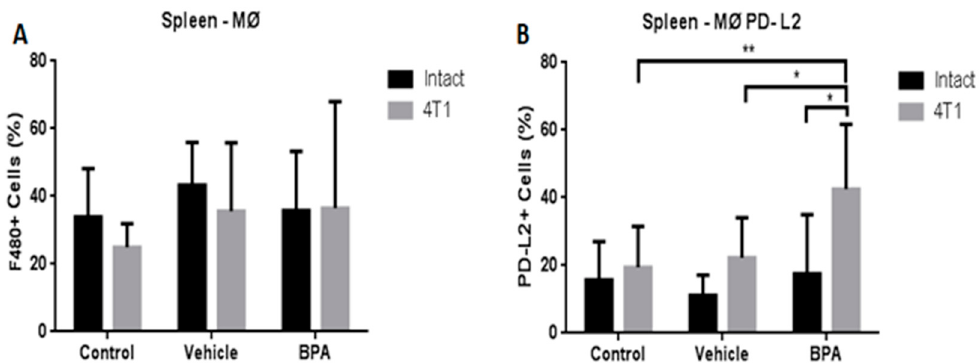
Figure 6. Percentages of total macrophages (MØ) and PD-L2+ macrophages (MØ-PD-L2) in the offspring of BPA treated animals. Macrophages ( A ), PD-L2 macrophages ( B ). Control ( n = 7), vehicle ( n = 6), vehicle/4T1 ( n = 7), BPA ( n = 7) and BPA/4T1 ( n = 5). Data are expressed as the mean and standard deviation of the population percentage. * p < 0.05, ** p < 0.01.